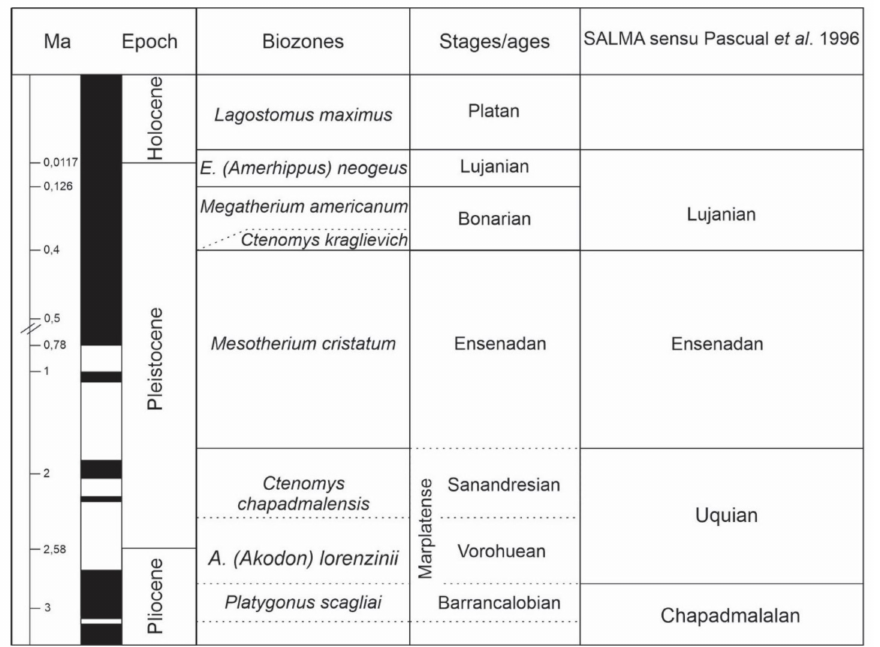
Figure 2. Stratigraphy correlation. Local biozones after Cione et al. [40] and Verzi et al.